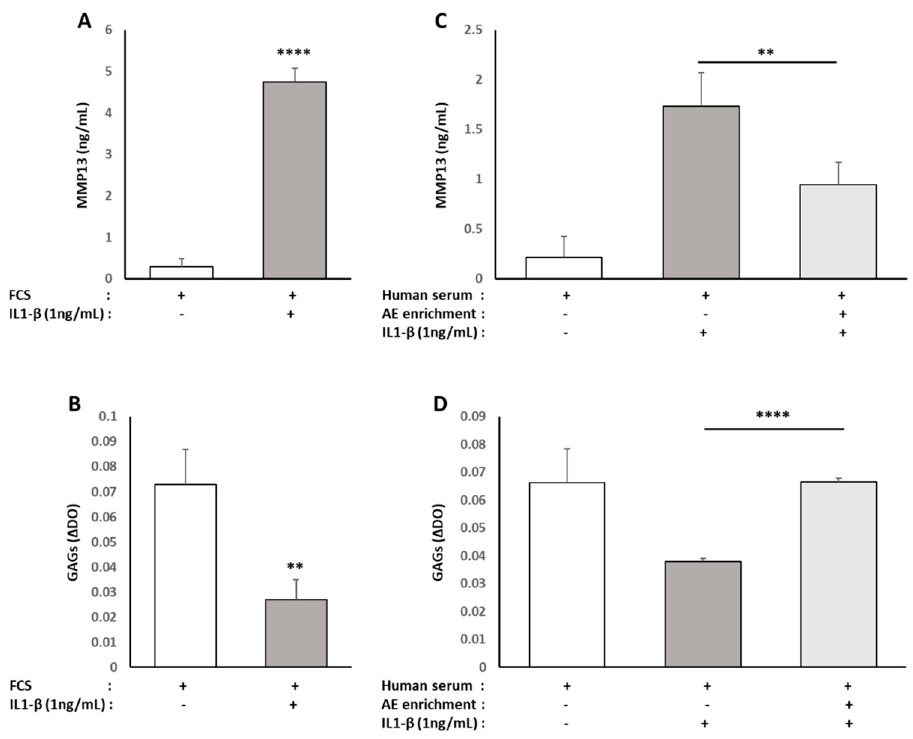
Figure 12. Effect of human serum enriched with ALE metabolites on catabolic actors (MMP13) and cartilage matrix production (Glyco-Amino Glycans/GAGs) in primary human articular chondrocytes: Human articular chondrocytes (HACs) were harvested from the tibial plateau and femoral condyles following knee replacement surgery and isolated. HACs were preincubated with fetal calf serum for 24 h and stimulated with IL-1 β (1 ng/mL) for an additional 24 h ( A , B ). To analyze the effects of human serum enriched with metabolites, cells were preincubated for 24 h in DMEM in the presence of 10% of human enriched serum according to the Clinic’n’Cell protocol (DIRV INRA 18-00058) prior to an additional 24 h treatment with human recombinant IL-1 β (Millipore Corporation, Molsheim, France) at 1 ng/mL ( C , D ). MMP13 release in culture media ( A , C ) and GAG cellular content ( B , D ) were measured. IL-1 β stimulated MMP13 release and reduced GAGs cellular content independently of the origin of the serum (calf or human). The human serum enriched with OPCO metabolites significantly reduced MMP13 release and limited the loss of GAGs production. ** ( p < 0.01); **** ( p < 0.0001).